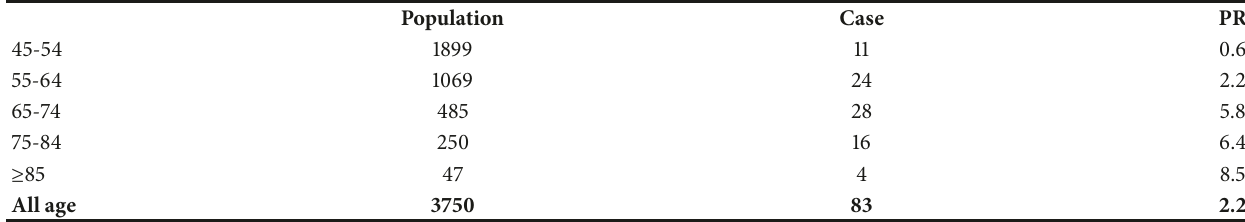
Table 3: Prevalence rate of stroke according age.